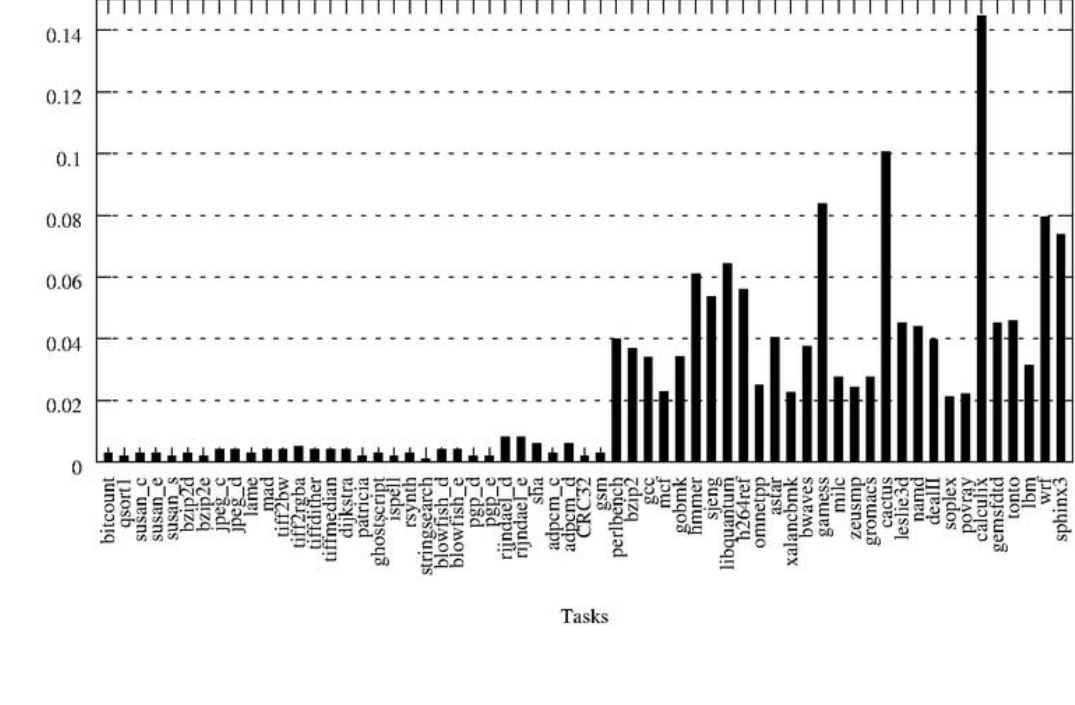
Figure 7. Energy profiling of the tasks in the Intel